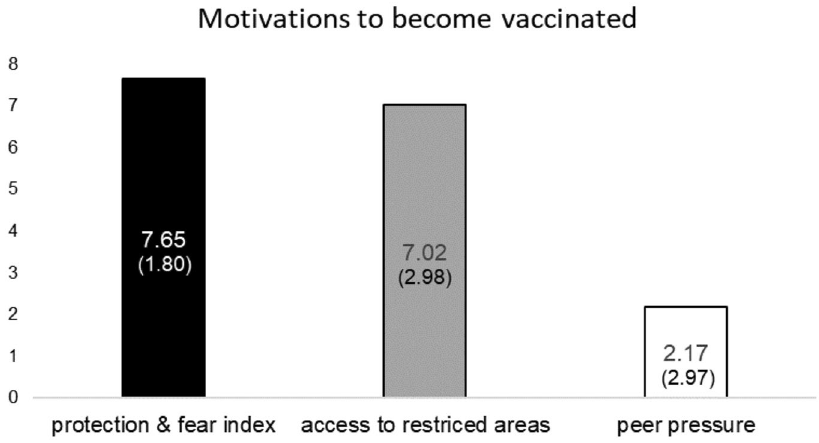
Figure 2. Participants’ stated motivations to become vaccinated.